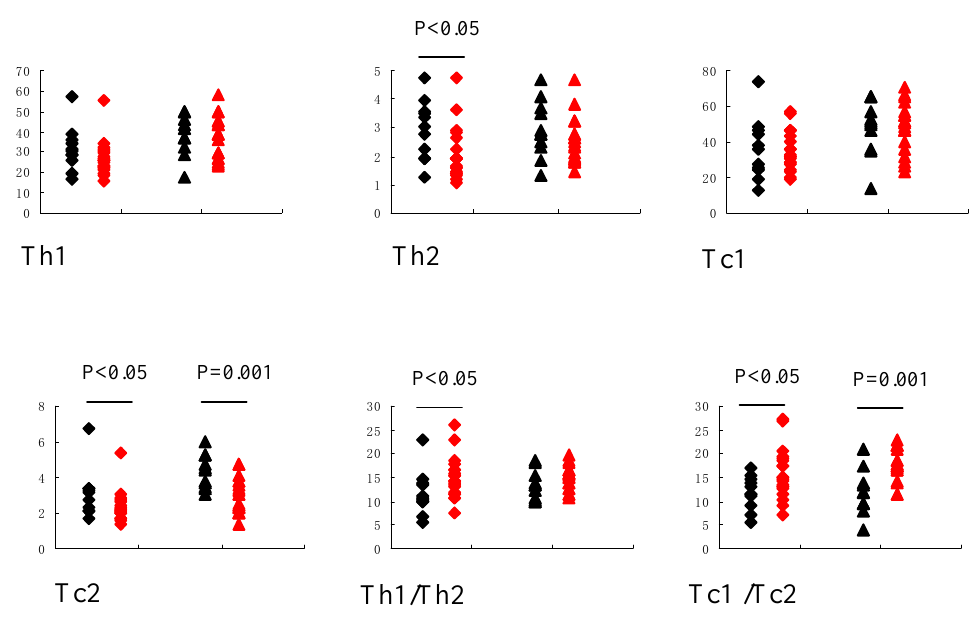
Figure 5. Individual percentages of Th1, Th2, Tc1 and Tc2 and ratios of Th1/ Th2 and Tc1/ Tc2 in preecalmptic patients and the controls. Rhombus, in blood. triangle, in deciduas. Black, the controls (n=11). Red, the preeclamptic patients